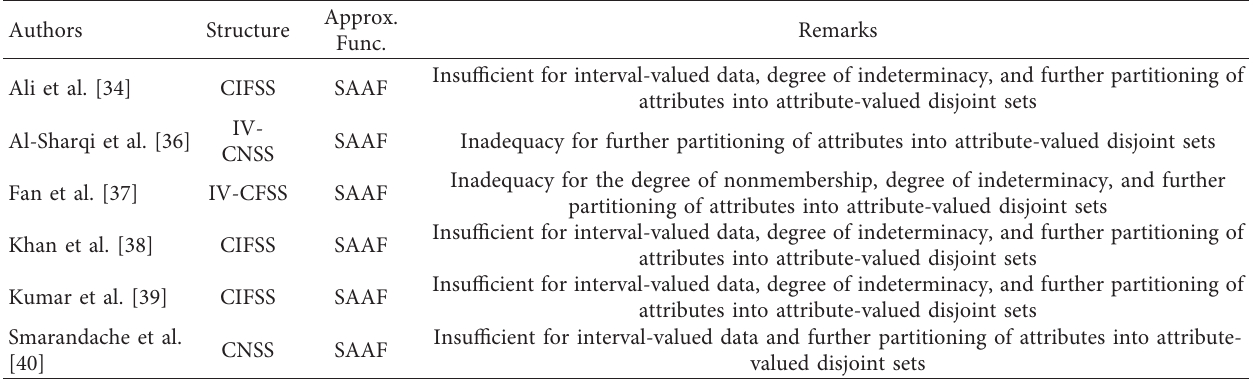
Table 7: Comparison of proposed structures with some existing relevant structures.